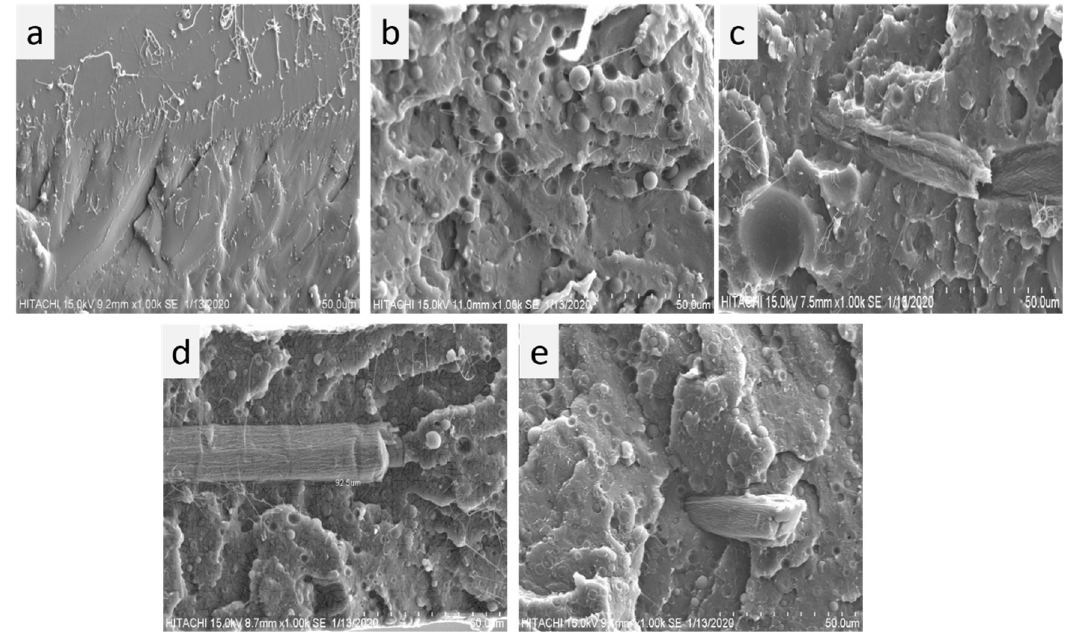
Figure 9. SEM morphology of the fractured surfaces of composite films: ( a ) M1, ( b ) M2, ( c ) M3, ( d ) M4, ( e ) M5.